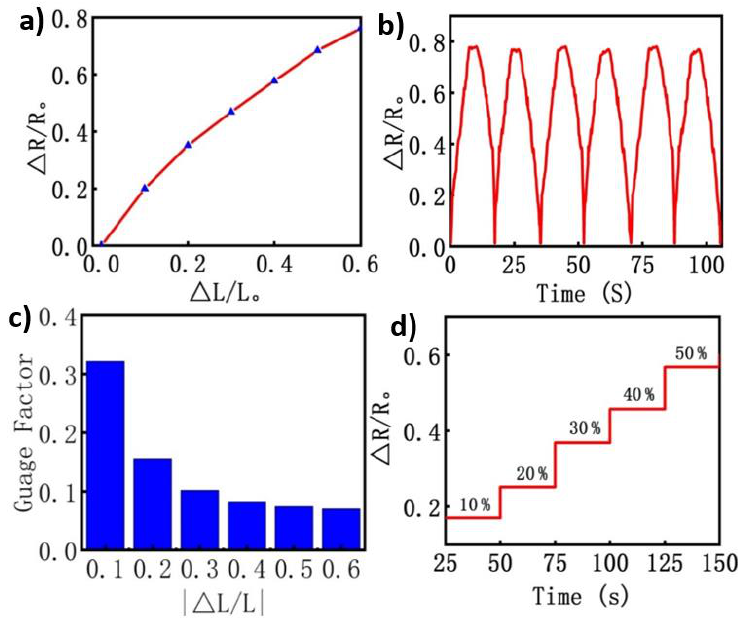
Figure 5. The typical mechanical sensing performance: ( a ) relative resistance change and the applied compressive strain as function of pressure at the rate of 5 mm/min; ( b ) plot showing stability of the normalized resistance change under repeatedly applied strain; ( c ) bar chart plotted for the calculated GF of the 3D porous piezoresistive tactile sensor, conductive for the various applied compressive strains (10% to 60%); ( d ) response of the sensor when the applied strain was gradually increased up to 60%.